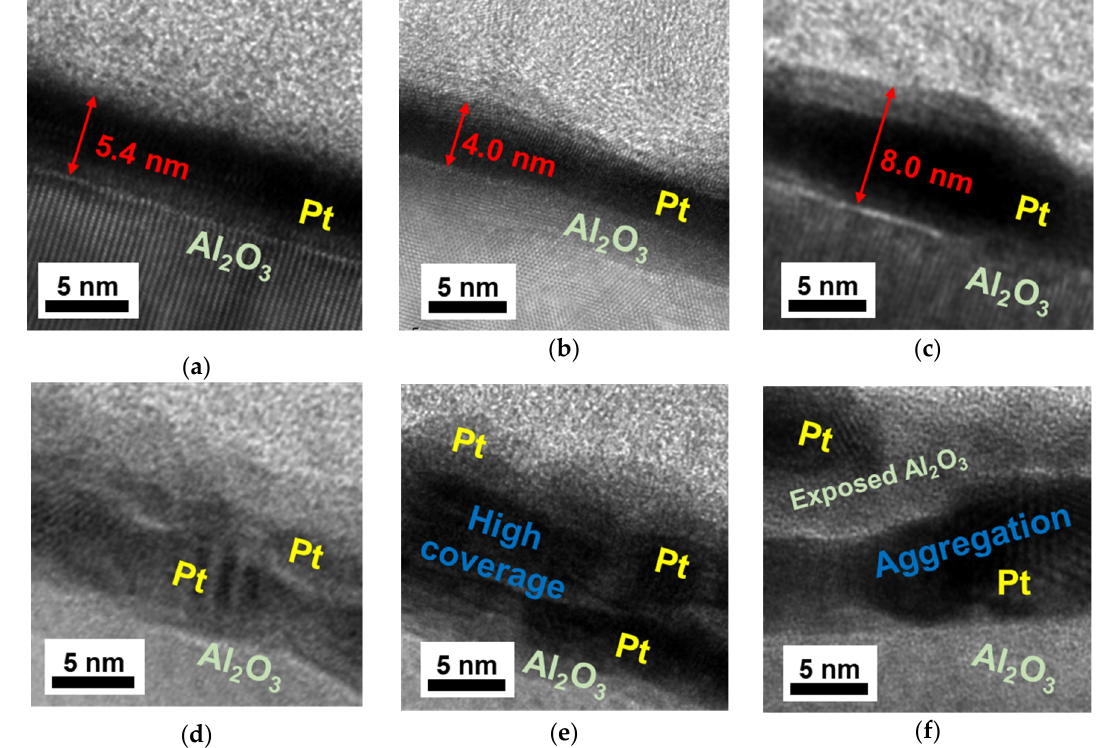
Figure 9. Cross-section TEM images of 60 s-sputtered Pt / Al 2 O 3 substrates calcined at 300 ◦ C, ( a ) side Figure 9. Cross ‐ section TEM images of 60 s ‐ sputtered Pt/Al 2 O 3 substrates calcined at 300 °C, ( a ) side view and ( d ) oblique view; those at 450 ◦ C, ( b ) side view and ( e ) oblique view and those at 570 ◦ C, ( c ) view and ( d ) oblique view; those at 450 °C, ( b ) side view and ( e ) oblique view and those at 570 °C, ( c ) side view and ( f ) oblique view. side view and ( f ) oblique view. Table 1. Structural property of 60 s-sputtered Pt / Al 2 O 3 calcined at various Table 1. Structural property of 60 s ‐ sputtered Pt/Al 2 O 3 calcined at various temperature.